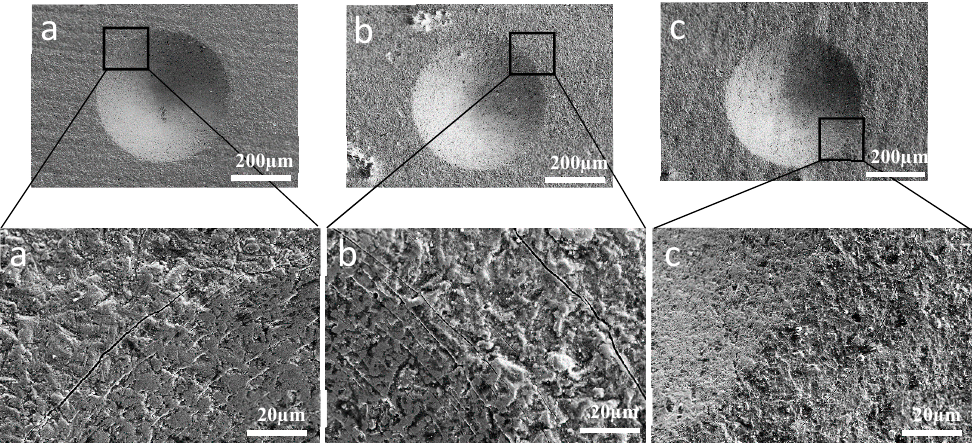
Figure 5. SEM micrographs after Rockwell C indentations with a load of 150 kgf on different coated surfaces ( a ) AlCrN; ( b ) AlTiN/Si 3 N 4 ; and ( c ) AlCrN/Si 3 N 4 .